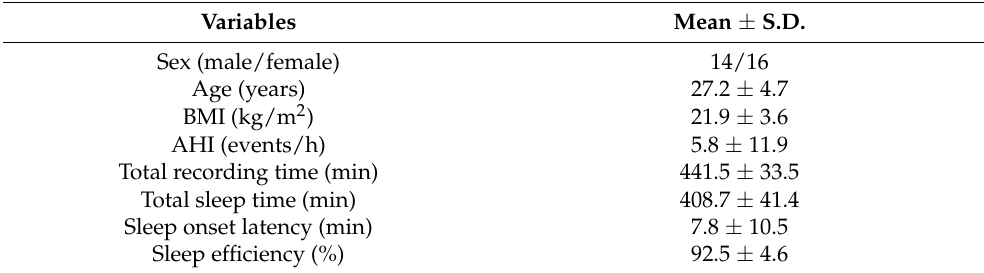
Table 1. Summary of sleep-related variables and subject characteristics (mean ± standard deviation,